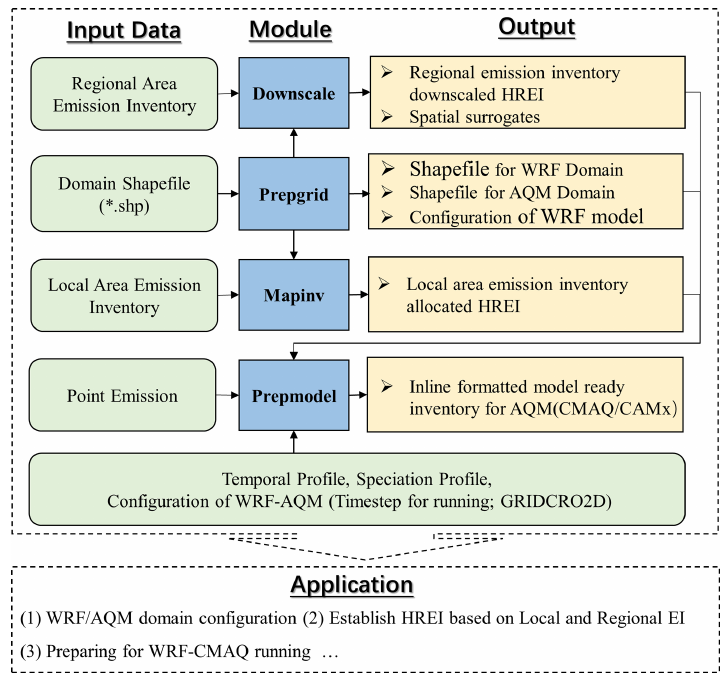
Figure 1. ISAT framework.